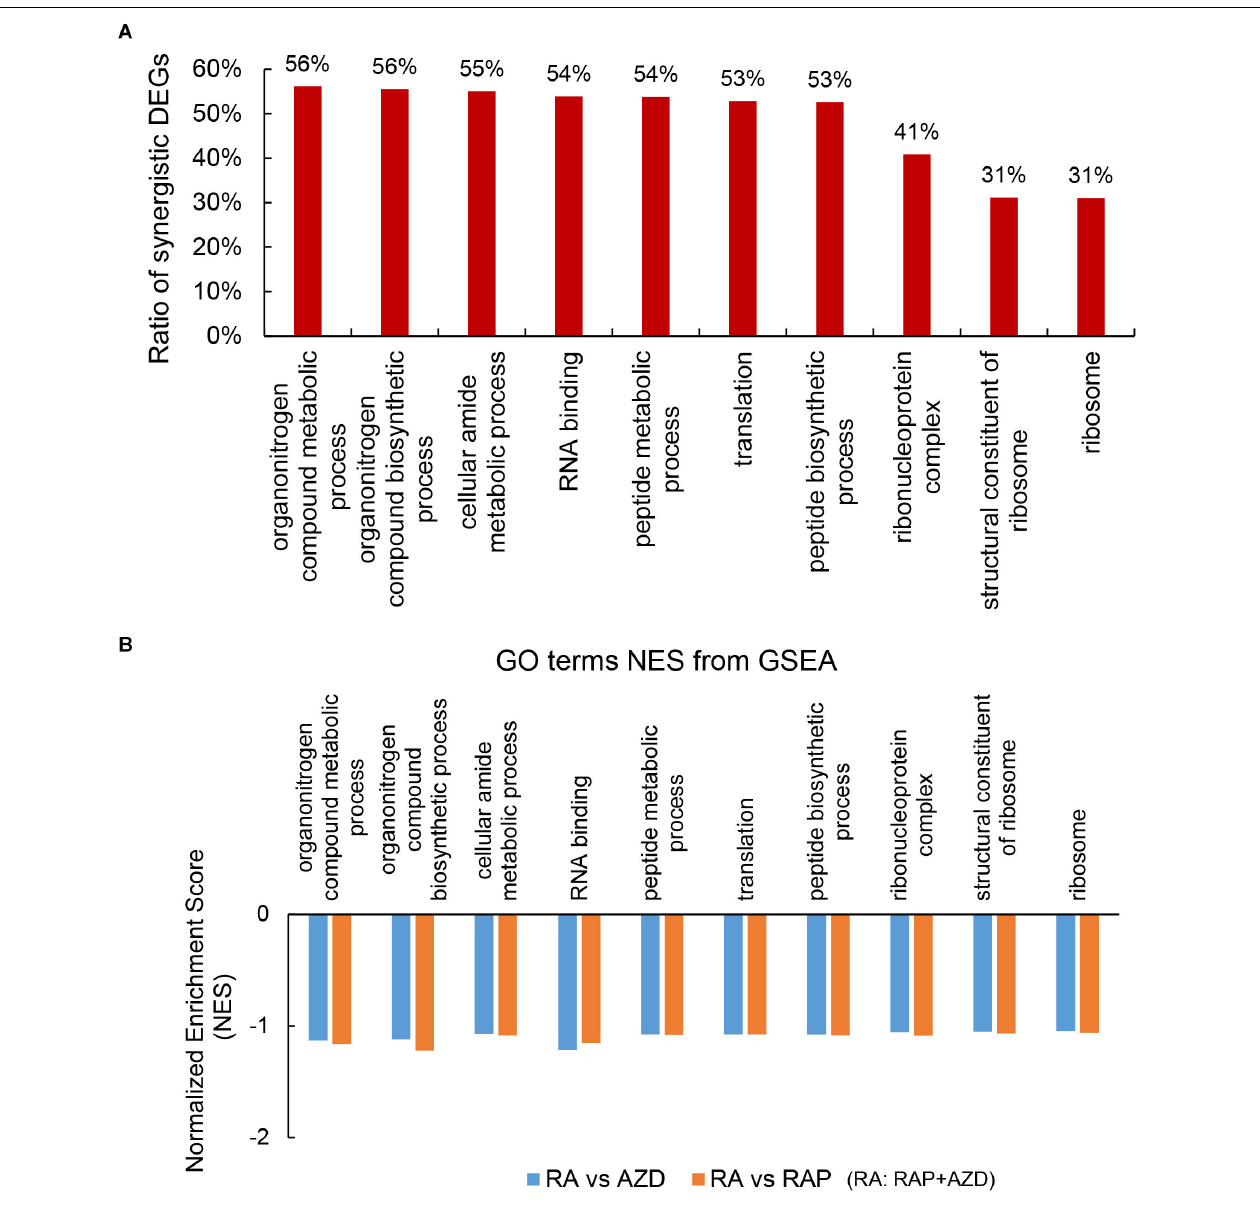
FIGURE 6 | Synergistic DEGs and gene expression trends in 10 co-existing GO terms after treatment with RAP + AZD. (A) Ratio of synergistic DEGs in the 10 co-existing GO terms. Ratio of synergistic DEGs = synergistic DEGs/total DEGs. (B) GSEA analyses of genesets for 10 co-existing GO terms. NES, normalized enrichment score. FDR, false discovery rate. Negative (–) and Positive (+) NES indicate down-regulated and up-regulated expression in RAP + AZD, respectively. All the FDR of 10 co-existing GO terms <